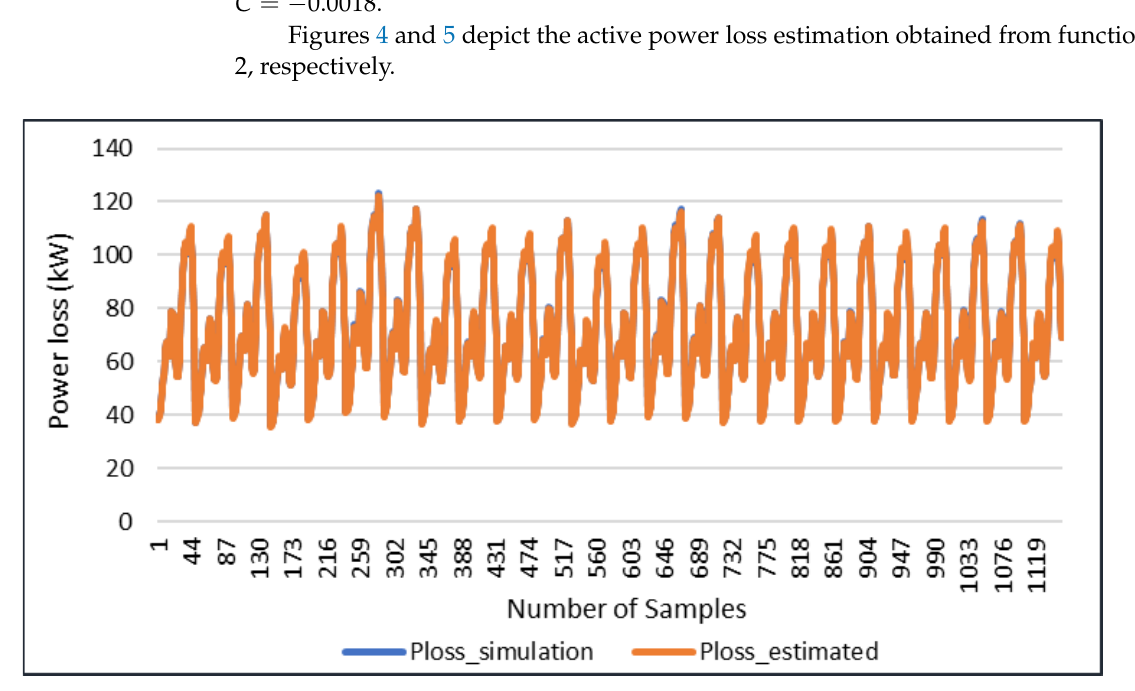
Figure 4. Active power loss obtained from function 1.